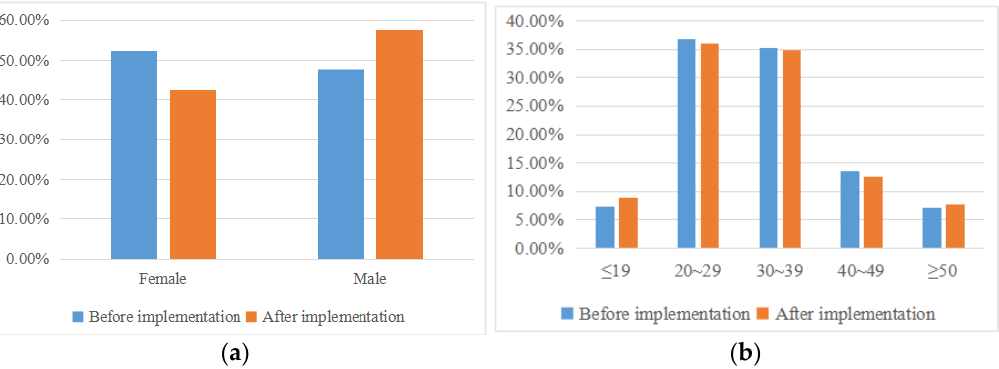
Figure 3. Change of audience before and after policy implementation. ( a ) Gender; ( b ) Age.